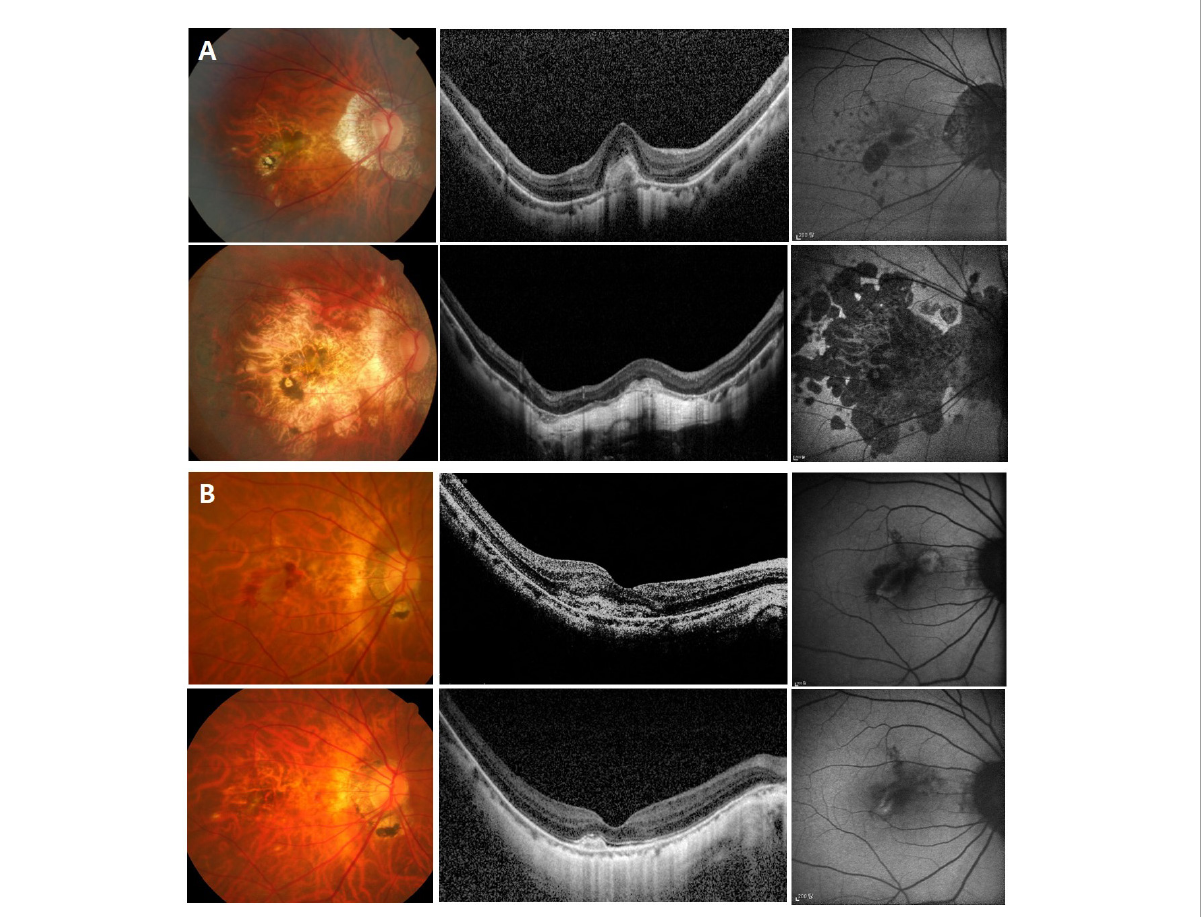
FIGURE2 Color fundus photo, optical coherence tomography, and fundus autofluorescence images showing the greater progression of macular atrophy and worse visual outcome of subfoveal myopic choroidal neovascularization (CNV) in an eye with higher β -PPA-to-disc area ratio (PDR) and tilt ratio (A) , compared to an eye with lower PDR and tilt ratio (B) . In panel (A) a 65-year-old female patient with an axial length of 28.7 mm. At baseline (the upper row), visual acuity was 0.63 in Snellen with the high β -PPA-to-disc area ratio (PDR) (4.53), tilt ratio (1.55), and subfoveal myopic CNV. During six years of follow-up, the patients underwent two recurrences and received nine injections. At the last visit (the lower row), visual acuity was deteriorated to counting finger with the development of extensive CNV-related macular atrophy. In panel (B) a 65-year-old female patient with an axial length of 29.2 mm. At baseline (the upper row), visual acuity was 0.32 in Snellen with the low β -PPA-to-disc area ratio (PDR) (0.68), tilt ratio (1.32), and subfoveal CNV. During eleven years of follow-up, the patients underwent one recurrence episode and received three injections. At the last visit (the lower row), visual acuity was maintained at 0.6 in Snellen with little occurrence of macular